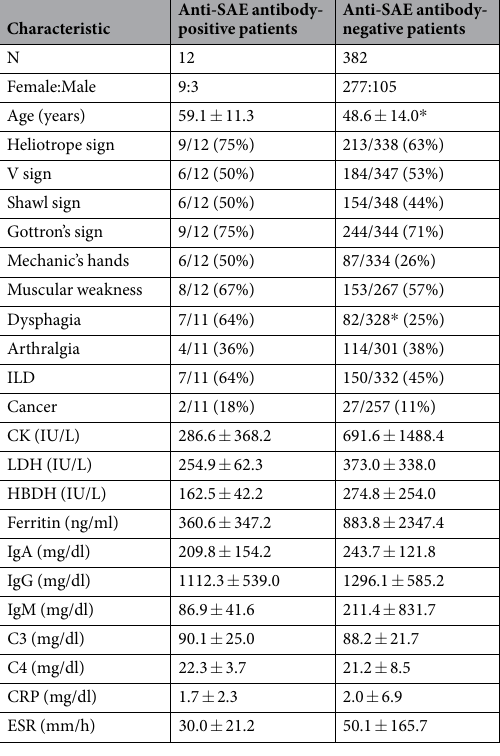
Table 2. Differences between anti-SAE antibody-positive group and antibody–negative group. LDH, lactate dehydrogenase; HBDH, hydroxybutyric acid dehydrogenase; C3, complement 3; C4, complement 4; Ig, immunoglobulin; * p < 0.05.